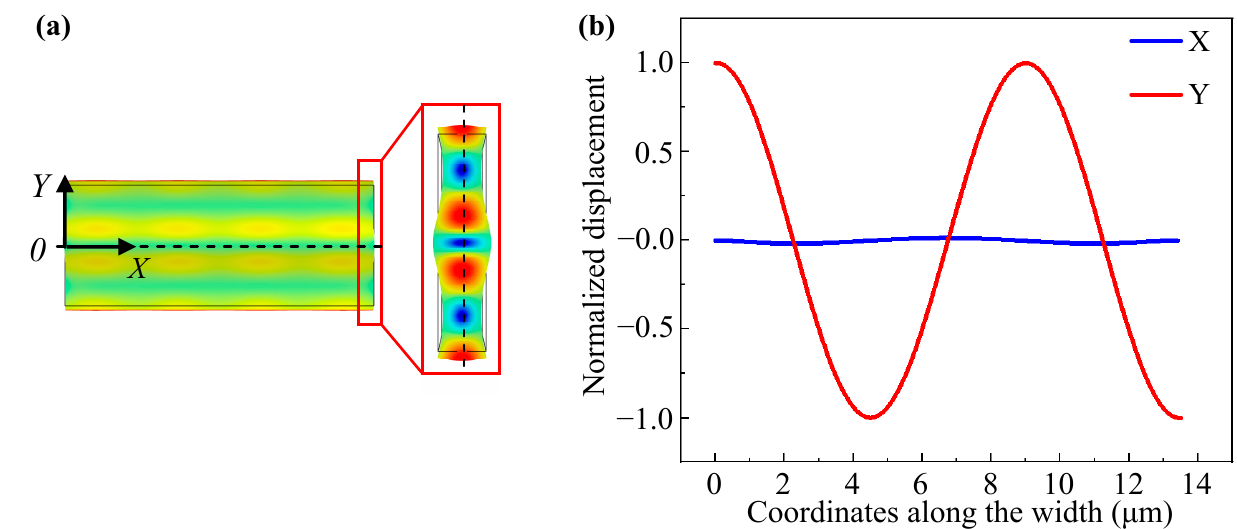
Figure 9. The spectra of the 3rd WEM resonators supported by ( a ) the straight tether and ( b ) the combined tether in vacuum.